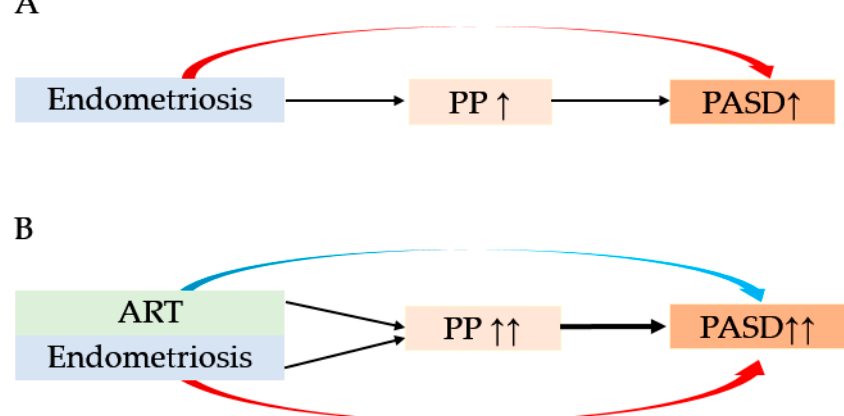
Figure 7. Our hypothesis of the possible mechanism of the increased rate of placenta accreta spectrum disorder. The red arrow indicates the effect of endometriosis on the increased rate of PASD. The light blue arrow indicates the effect of assisted reproductive technology (ART) on the increased rate of PASD. ( A ) For women with endometriosis who conceived without ART, endometriosis itself may be associated with an increased rate of PASD. Because endometriosis is associated with an increased rate of placenta previa, this may indirectly contribute to a higher rate of PASD. ( B ) For women with endometriosis who conceived using ART, ART may have an additive effect that increased the rate of placenta previa and PASD. As a result, we believe that women with endometriosis who conceived using ART are at a high risk for PASD. Abbreviations: PP, placenta previa; PASD, placenta accreta spectrum disorder, ART, assisted reproductive technology.